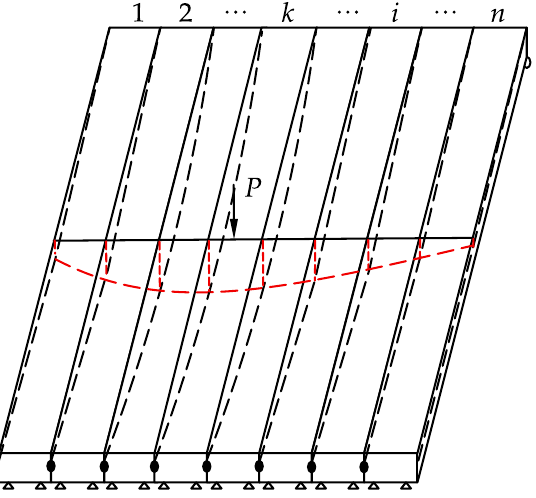
Figure 1. A typical articulated slab subjected to a concentrated force.